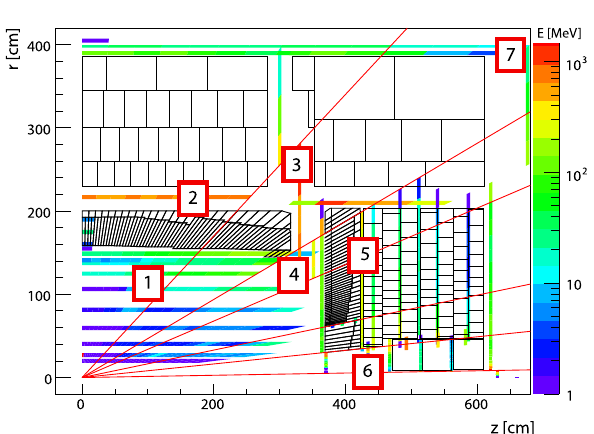
Fig. 17 The average energy loss in the virtual dead material cells for charged100GeVpions. Thenumbers 1–7indicatethedifferentregions, with region 8 (not displayed) being everywhere outside regions 1–7. The dead material cells are superimposed on a schematic ( r , z ) view showing a quarter of the ATLAS calorimeter system with its read-out segmentation sampling layer s is used to assign the dead material energy to topo-clusters. For a given cluster k out of N clus topo-clusters which have cells from s included, the assignment weight w is calculated using